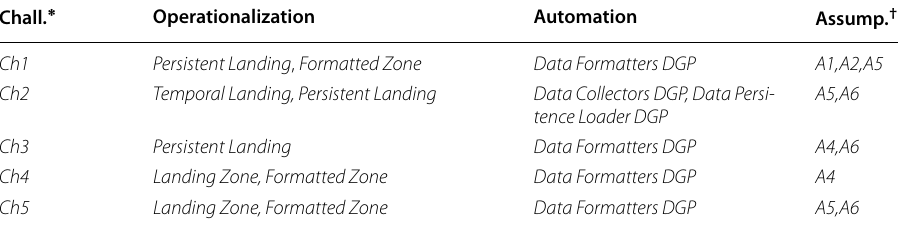
Table 1 Challenges addressed in our framework, including what components provided operationalization and automation of data